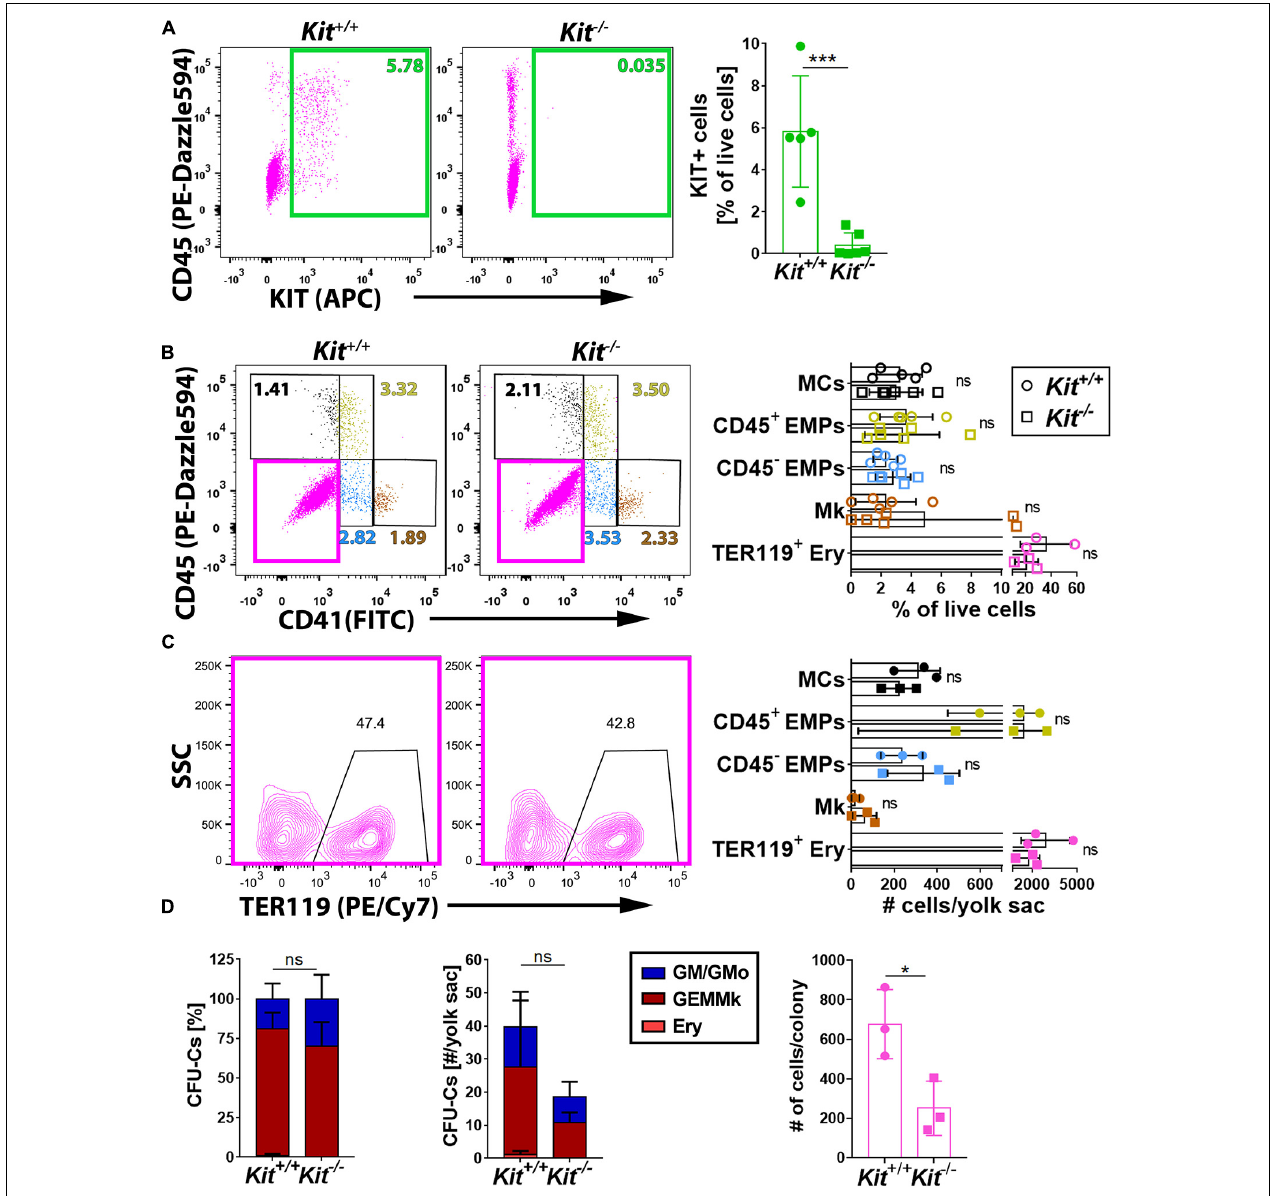
FIGURE 2 | KIT is dispensable for yolk sac hematopoiesis. (A) Flow cytometry analysis of single living cells from E9.5 Kit + / + and Kit − / − littermate mouse yolk sacs ( n = 5 each) with the indicated markers. The green boxes in the scatter plots indicate the gates used to determine the percentage of KIT + cells. Data are shown as mean ± SD; each data point represents the value from one embryo; *** p < 0.001 (unpaired Student’s t -test). (B,C) Flow cytometry analysis of single living cells from E9.5 Kit + / + and Kit − / − ( n ≥ 3 each) littermate mouse yolk sacs with the indicated markers. The color-coded boxes or annotation in the scatter plots indicate the gates used to determine the percentage (top bar graph) as well as the embryo equivalent number (bottom bar graph) of cell populations defined by CD45, CD41, or TER119 expression levels. Data are shown as mean ± SD; each data point represents the value from one embryo; non-significant (two-way ANOVA followed by Sidak’s multiple comparisons test). (D) Quantification of the percentage (left panel), number (center panel), and colony cell number of CFU-C (right panel) in Kit + / + versus Kit − / − littermate E9.5 yolk sacs ( n = 3 each). Each data point represents the value from one embryo; stacked bar graph data are shown as mean ± SEM; ns, non-significant (two-way ANOVA); bar graph data are shown as mean ± SD; * p < 0.05 (unpaired Student’s t